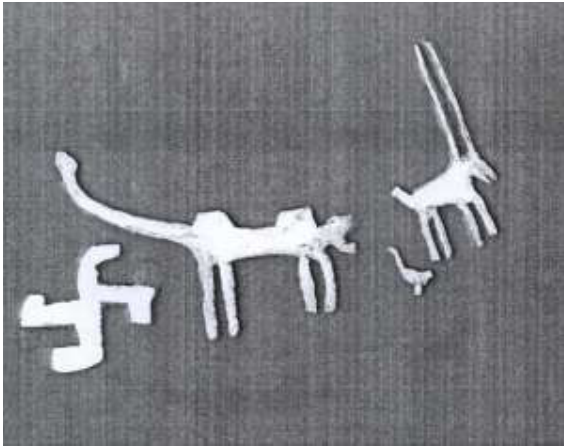
Figure 11. Saral, valley of Bayenchou village, depictions of a swastika and three zoomorphs.